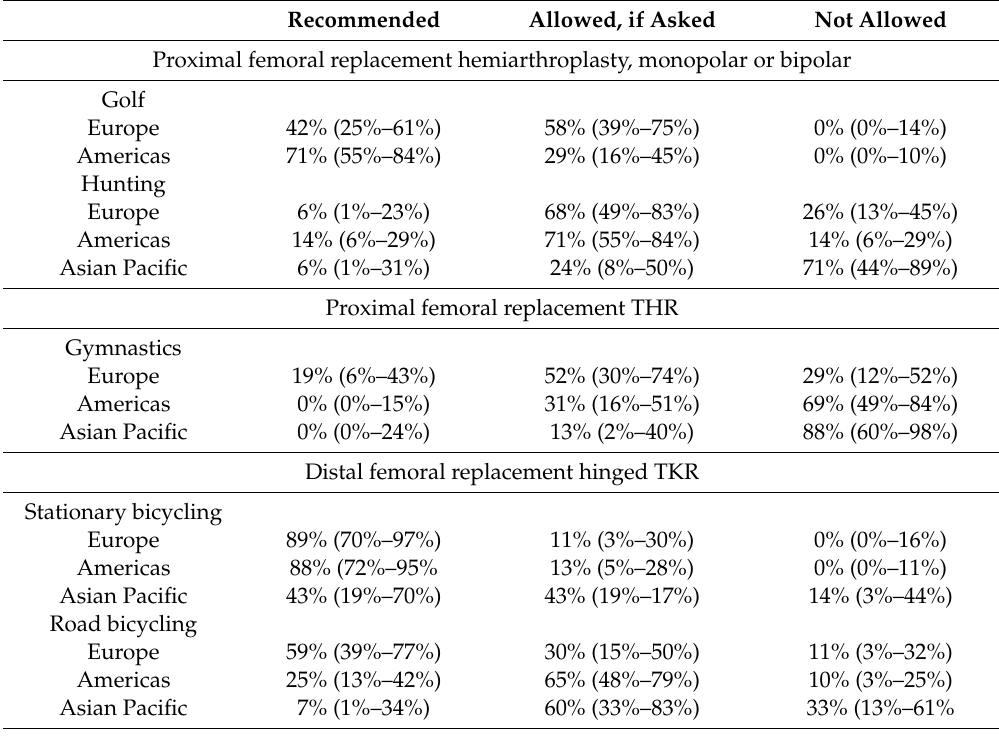
Table 4. Proportions (and 95% confidence intervals) of recommended, allowed, and not allowed sports after surgery by regions. Listed sports di ff ered significantly between regions. Recommended Allowed, if Asked Not